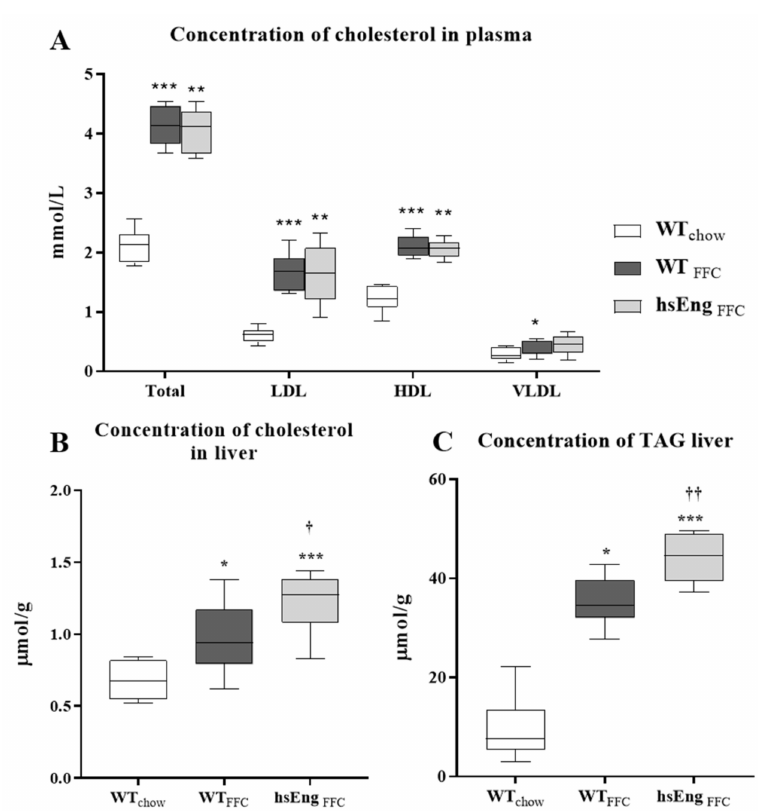
Figure 4. Cholesterol levels in blood and cholesterol and TAG concentration in mice liver. Cholesterol concentration in plasma ( A ). The concentration of cholesterol ( B ) and TAG ( C ) in the liver. The data are presented as median with box and whiskers representing the interquartile range and 5th–95th percentiles ( n = 8). * p < 0.05, ** p < 0.01, *** p < 0.001, using the Kruskal–Wallis test; † p <